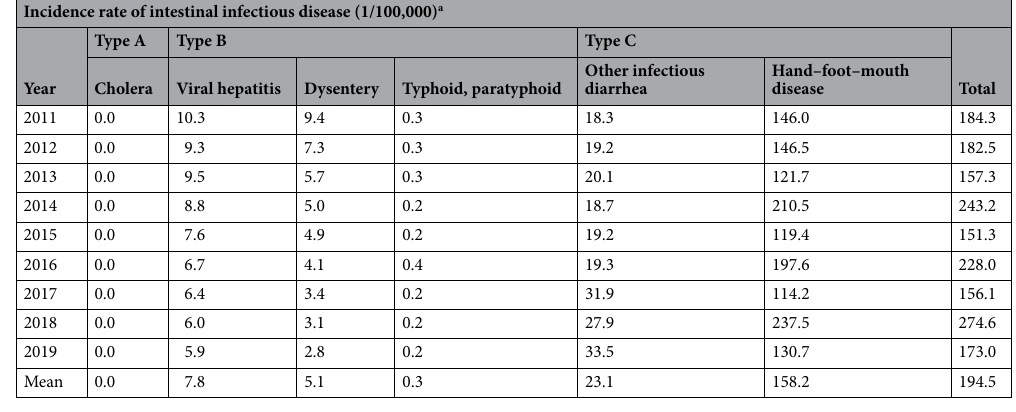
Table 1. Annual incidence rate of each intestinal infectious disease in Jiangsu Province for each year during 2011–2019. The permanent residents of Jiangsu Province in 2019 amounted to 80.7 million. a Annual incidence rates were calculated as Eq.